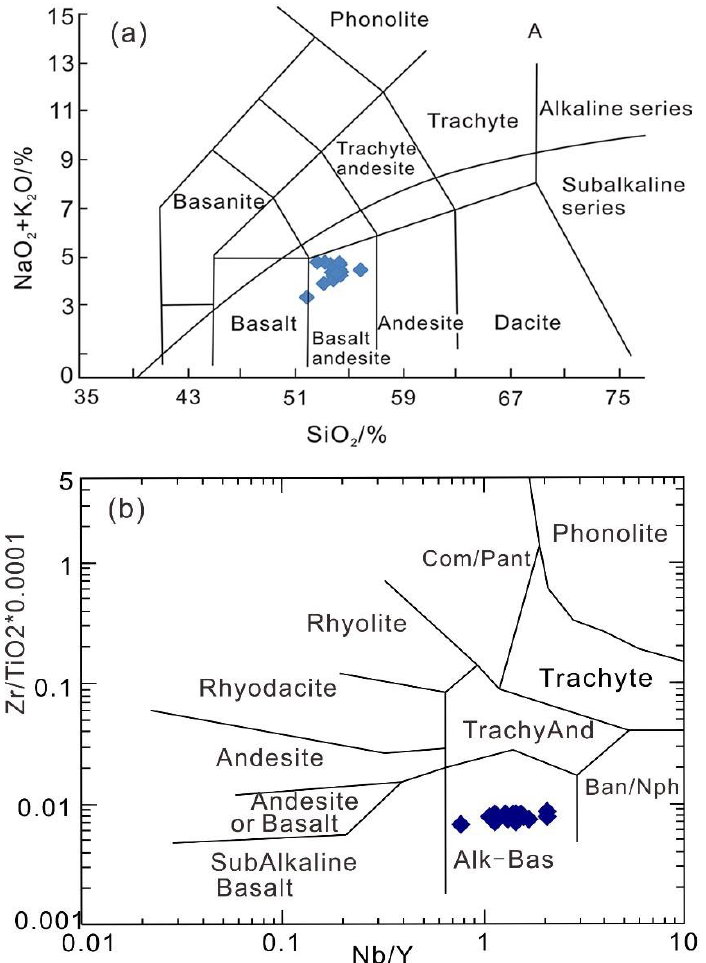
Figure 4. ( a ) Na 2 O + K 2 O vs. SiO 2 classification diagram for volcanic rocks from the Jiangling Basin. ( b ) Zr/TiO 2 *0.0001-Nb/Y classification diagram for volcanic rocks from the Jiangling Basin (after [63]).